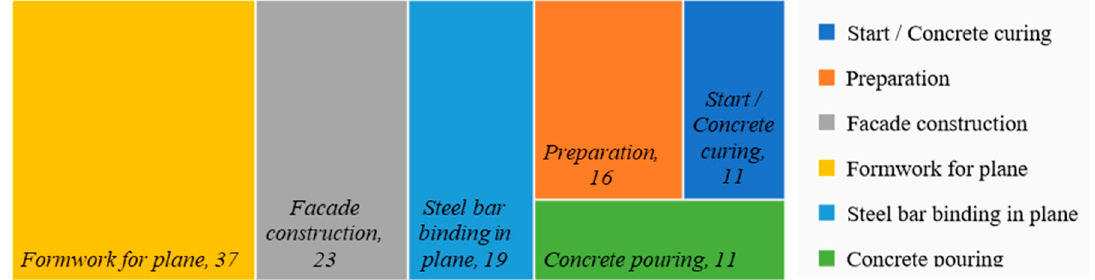
Figure 8. Image distribution.